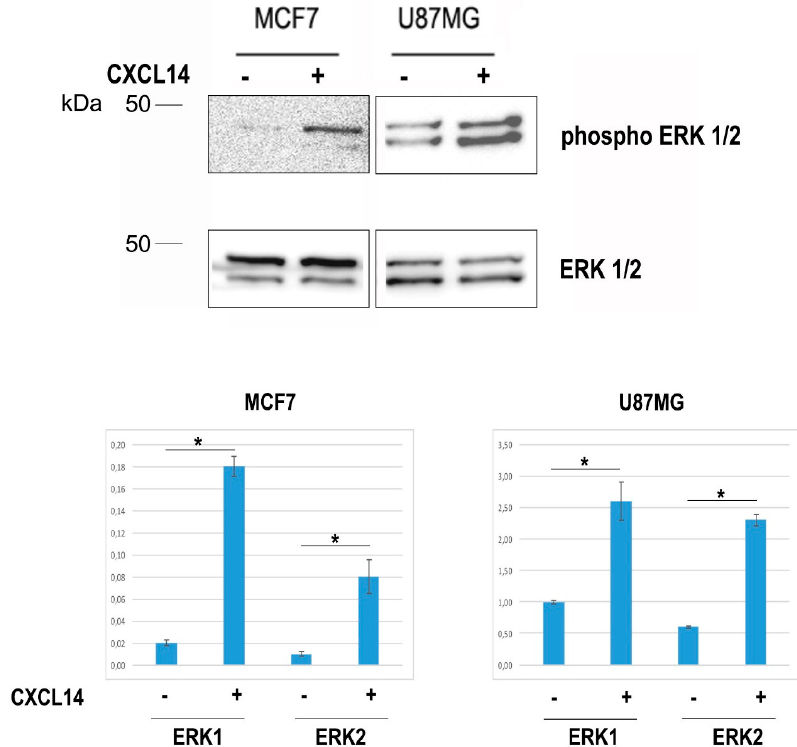
Figure 3. The treatment with CXCL14 induces the phosphorylation of ERK1 and ERK2 in U87MG cells. Representative Western blot showing total (ERK1 / 2) ( lower panel ) and phosphorylated (phospho-ERK1 / 2) ERK1 / 2 ( upper panel ) proteins in total protein extracts of MCF7 or U87MG cells treated or not with recombinant human CXCL14 (400 ng / mL). The graphs show the densitometric quantification of the detected bands, and represent the average ( +/ − st. dev.) of three independent experiments. The panel relative to MCF7 cells, assayed as positive controls of CXCL14 action on ERK phosphorylation, was produced after a longer exposure, in order to reveal the faint bands present in untreated cells. * p <